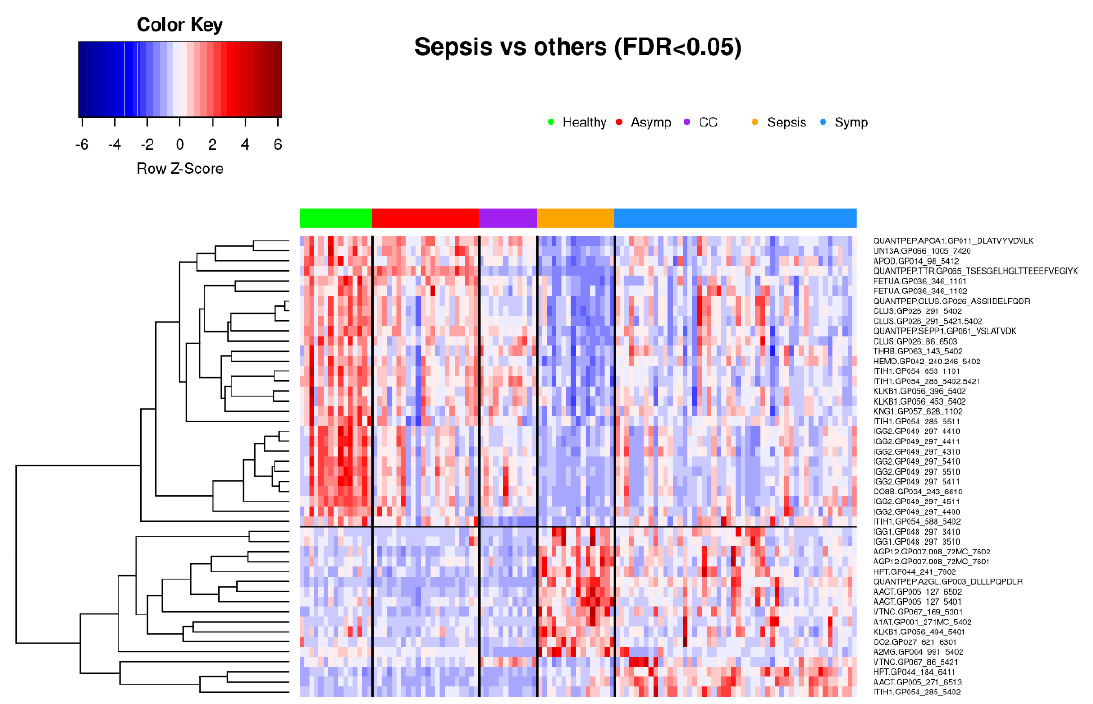
Figure 8. Fort–six biomarkers that achieve FDR < 0.05 in differential expression analysis between sepsis and all four of the other phenotype groups separately. Subjects are clustered into phenotype groups column-wise and hierarchically clustered row-wise. Row-wise Z-scores determine the color of each cell. CC: Common cold coronavirus.